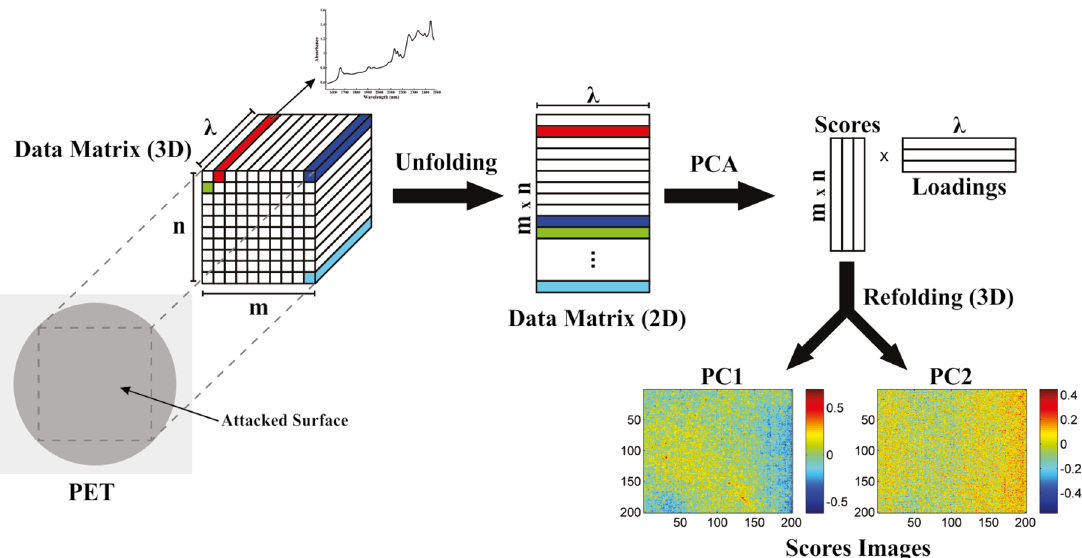
Figure 2. Schematic representation of the PCA in NIR hyperspectral image of the PET showing the hypercube (3D) unfolded into a 2D matrix and the relationship between scores and loadings of the PCA